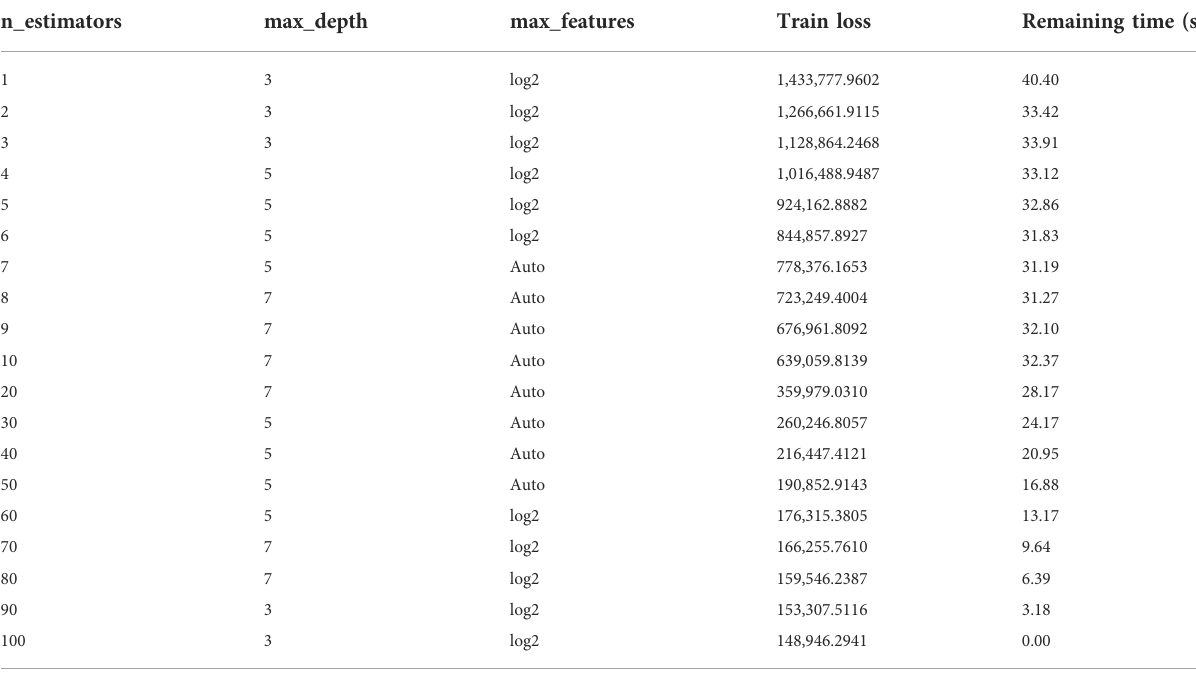
TABLE 4 Parameter selection grid table.